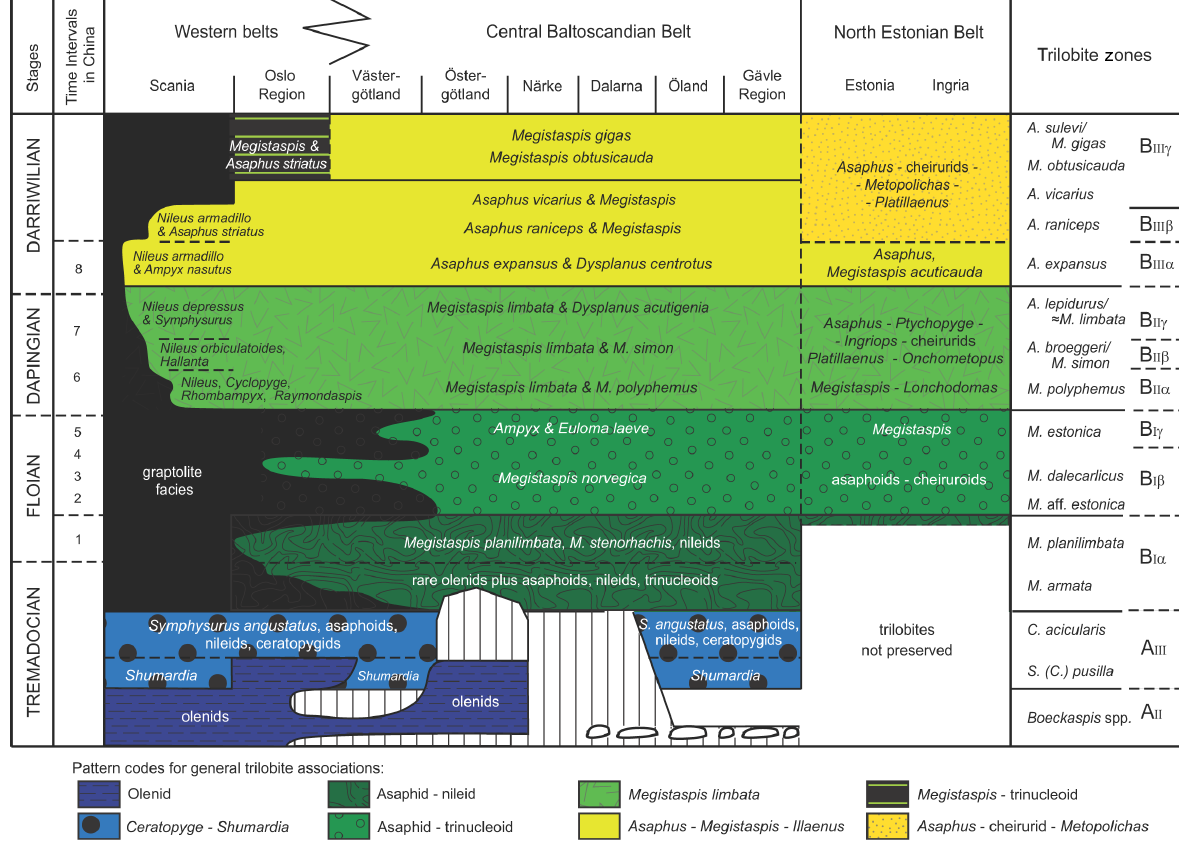
Fig. 5. Biofacies associations in Baltoscandia with regional dominance variations. There are only three major biofacies: the Olenid (shown with horizontal stripes), Ceratopyge (shown with black circles) and (western) Asaphid biofacies (all other patterns except the previous two marking different variations in association), with evolutionary and local/regional differences mostly on the species level. A strong regional differentiation occurs only in the Darriwilian, where the Oslo Region and the North Estonian Belt have rich trilobite faunas that share only a few species, and the Central Baltoscandian Belt has an impoverished fauna, consisting of a single species in many localities. The trilobite sub-biofacies are marked with different patterns (see the legend on the bottom of the figure) and the most characteristic taxa are pointed out below the